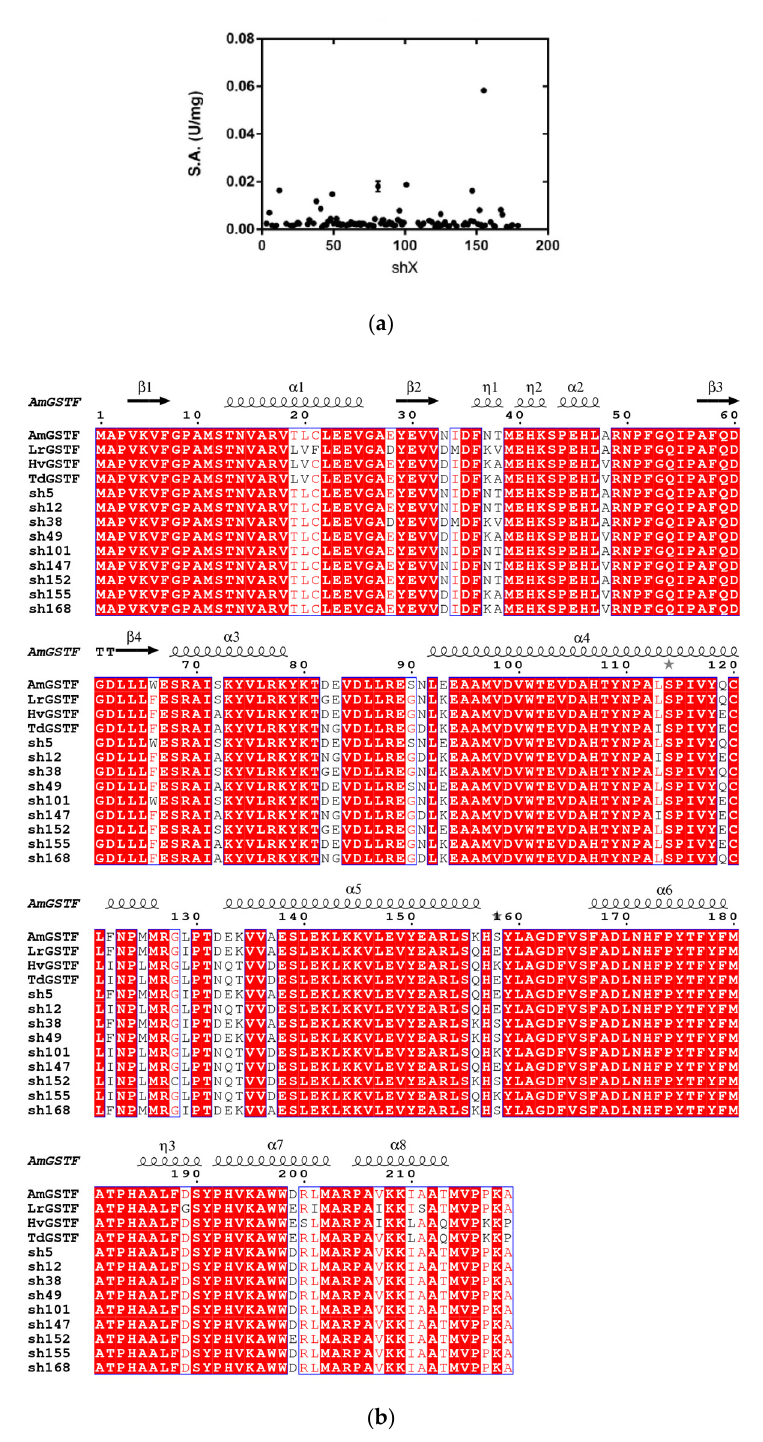
Figure 1. ( a ) Activity screening of colonies obtained by DNA shuffling. Only the colonies that displayed detectable activity with the substrate system CDNB/GSH are depicted. ( b ) Protein sequence alignment of parent GSTFs (NCBI accession numbers Am GSTF: CAA09192.1, Lr GSTF: CCO25537.1, Hv GSTF: AAL73394.1, Td GSTF: VAH13982.1) and selected variants obtained by DNA shuffling. Shaded areas displayed a similarity score value over 0.7 (0 to 1 range) based on their physicochemical properties. The letters are colored based on similarity using the “Thermal” option in ESPript 3.0 [43]. The secondary structure of Am GSTF (PDB code: 6RIV) is shown at the top. Alpha helices and beta strands are represented as helices and arrows, respectively. Beta turns are marked with TT. Initial alignment was accomplished by Clustal Omega [44].